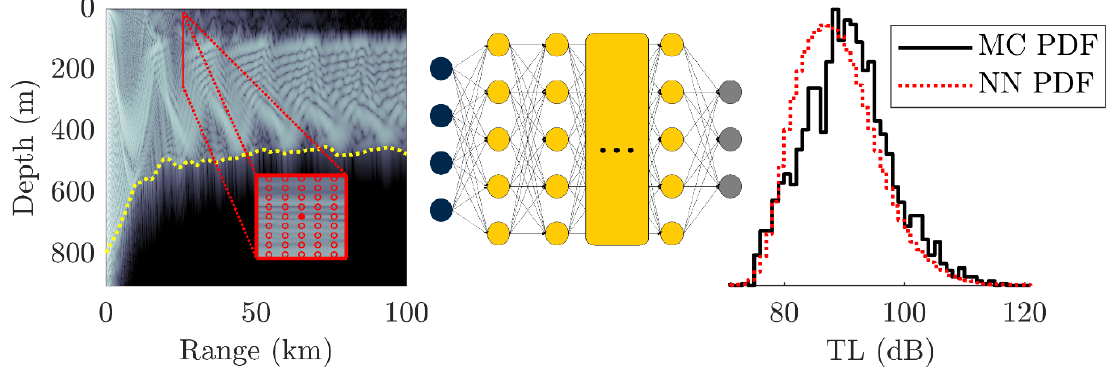
Figure 1. Elements of the proposed machine learning technique for estimating the probability density function (PDF) of transmission loss (TL). A simple, feedforward neural network (NN) diagram is shown between the model’s inputs on the left and outputs on the right. The inputs are values from a single baseline TL solution surrounding the point of interest (POI), and the output is a predicted estimate of the Monte Carlo (MC) PDF of TL at that POI resulting from environmental